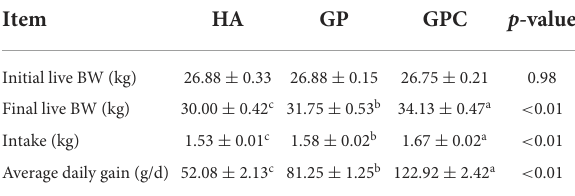
TABLE 2 Intake and growth performance of lambs fed non-pelleted native grass hay without or with concentrate or